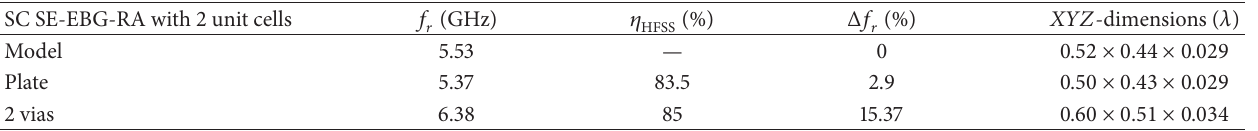
Figure 1: SC SE-EBG-RA composed of two unit cells: (a) with a shorting plate and (b) with vias acting as shorting plate; traces are 30 𝜇 m copper; the 𝜆 /4 transformer is 2.45 mm wide and 6.96 mm long; the via radius is 0.25 mm; 28 mm × 24 mm ( 𝑋𝑌 ); substrate is 1.6mm thick RO4350B. Table 1: HFSS-simulated properties of the antennas in Figure 1 as compared with the circuit model results; Δ is the change in 𝑓 𝑟 , divided by 𝜆 is calculated at 𝑓 𝑓 𝑟 given by the model; 𝑟